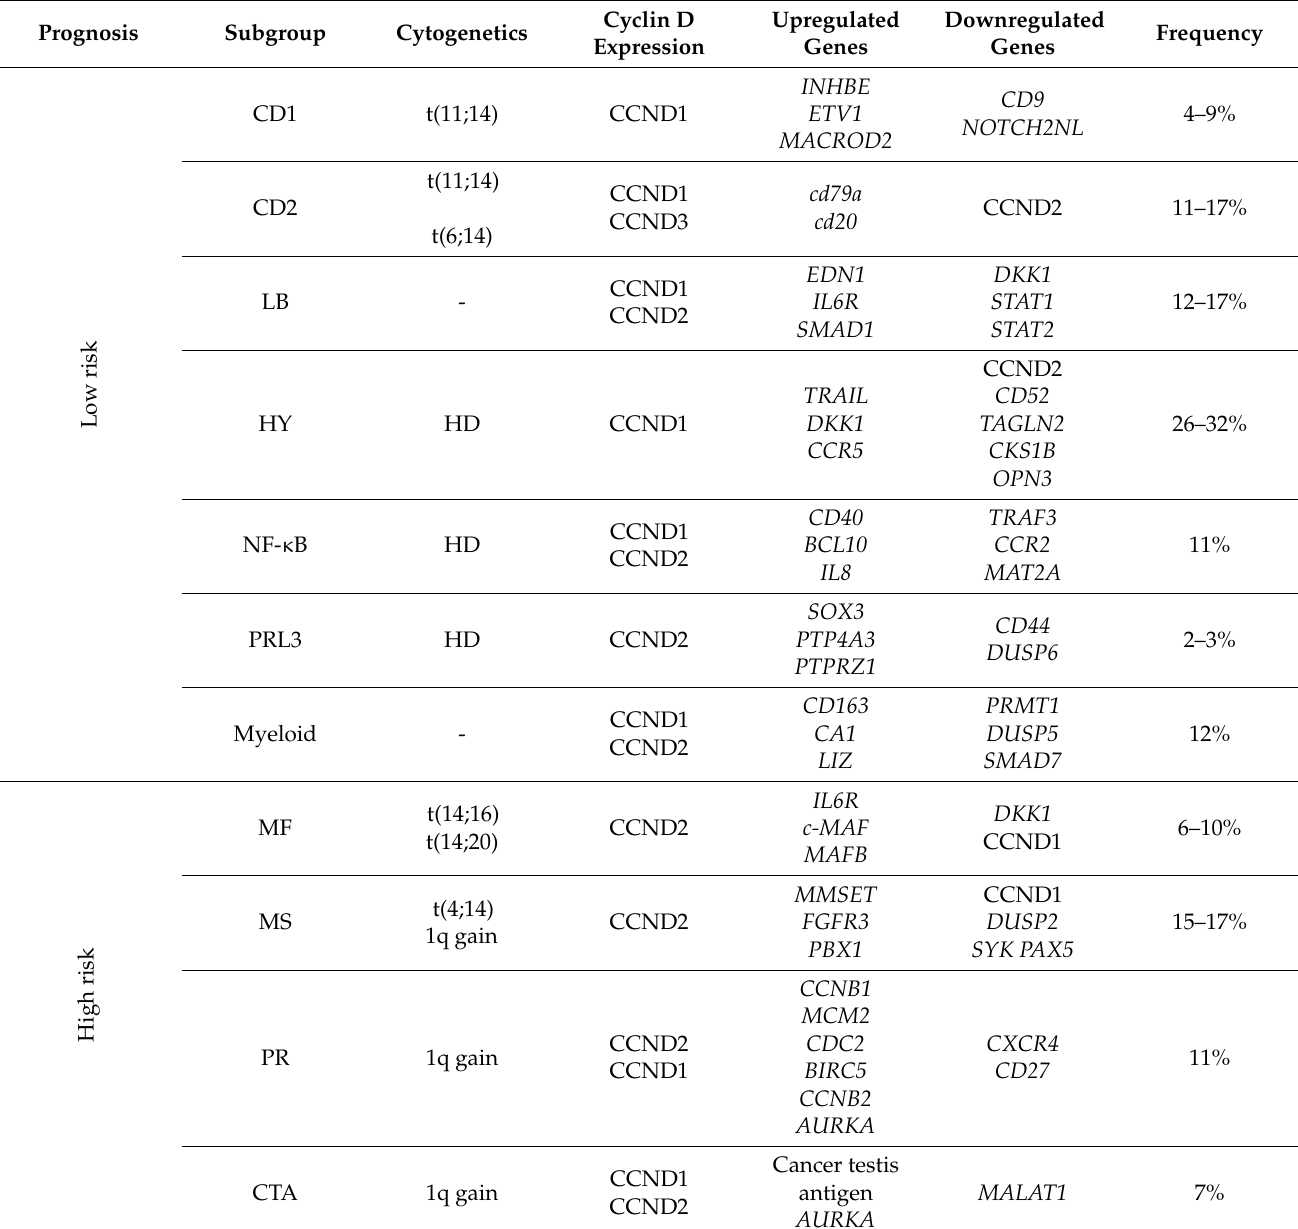
Table 1. The identification of 11 molecular subgroups of incorrectly expressed genes using gene expression profiling.